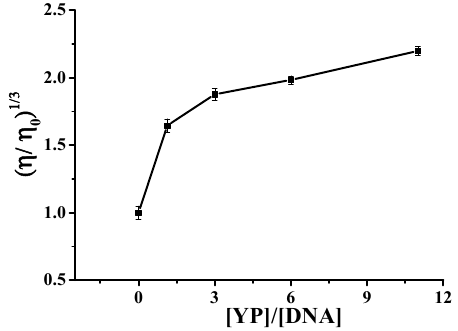
Figure 6. Relative viscosity of DNA–YP complexes in the presence of different YP concentrations .